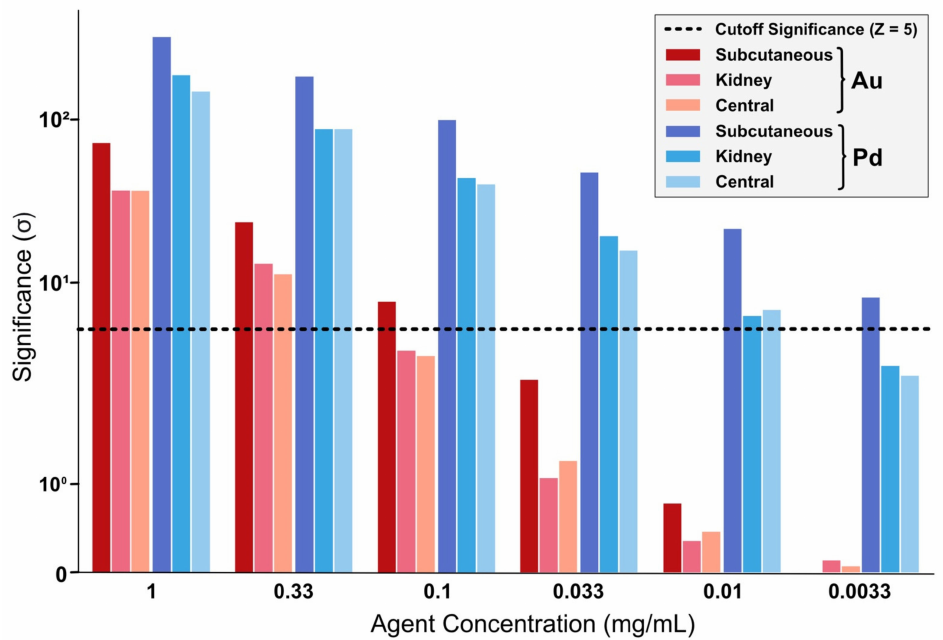
Figure 3. Comparison of a subcutaneous, a kidney and a centered target regarding Au-fluorescence (red) and Pd-fluorescence (blue)